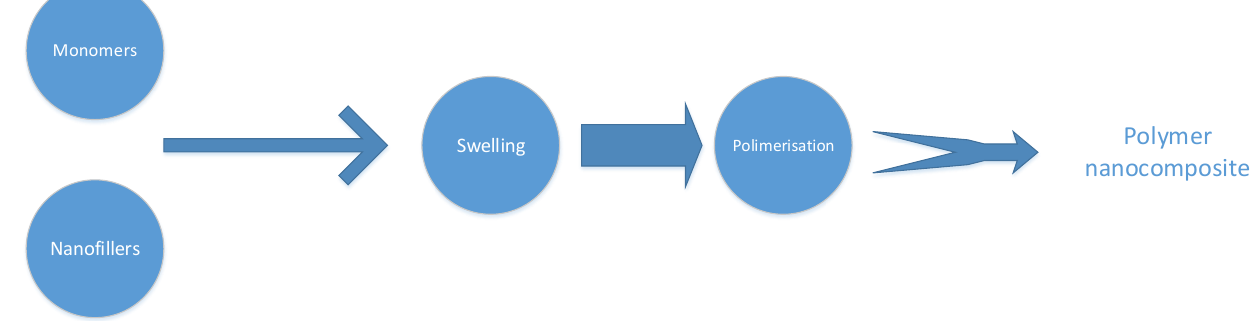
Figure 2. Steps for PNC fabrication using in situ polymerisation.